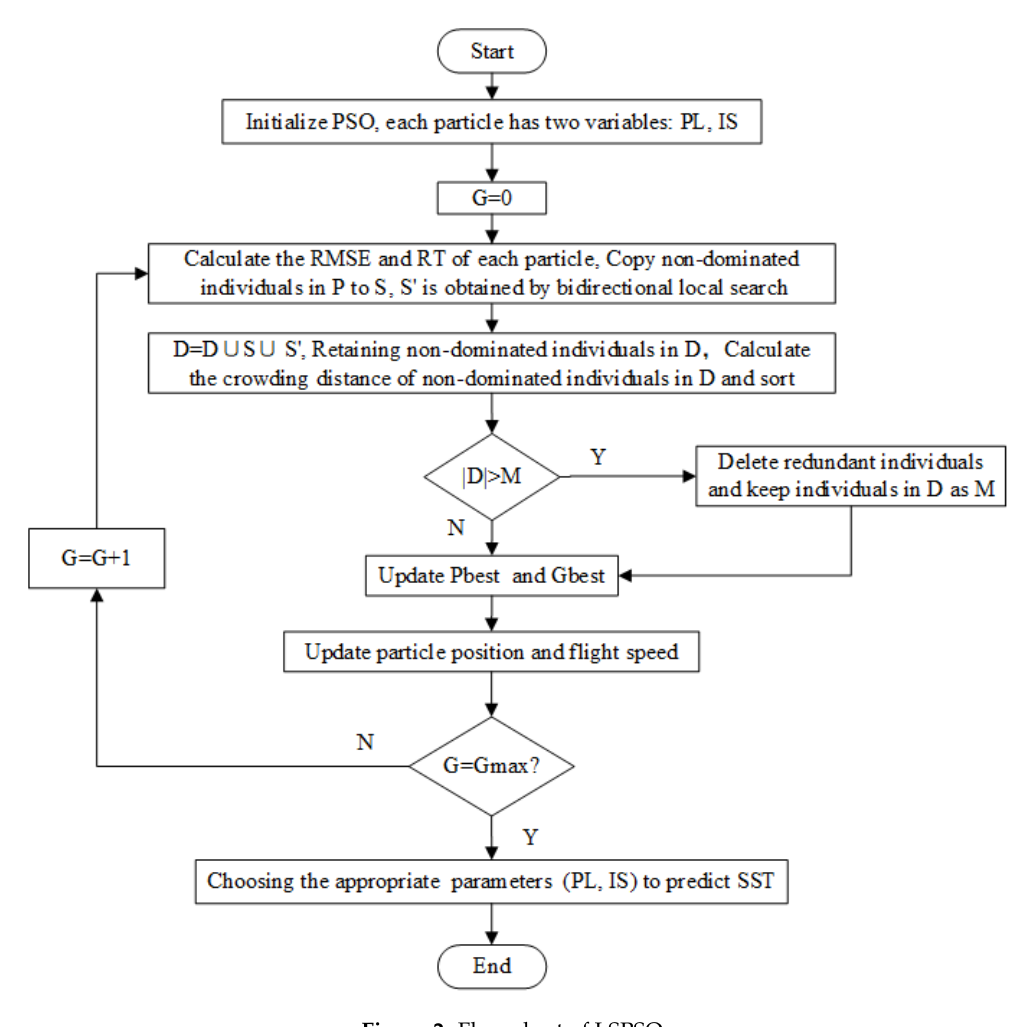
Figure 2. Flow chart of LSPSO.